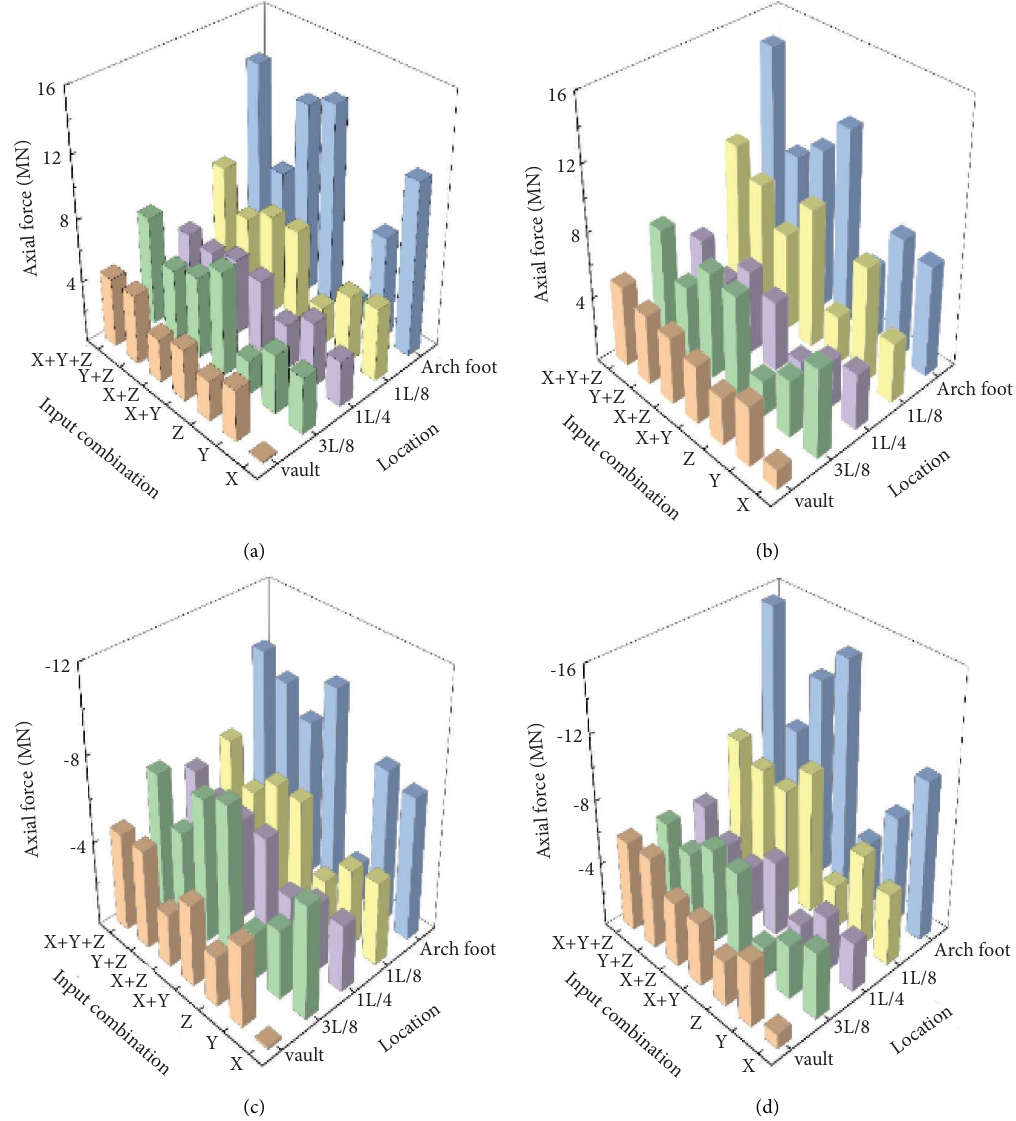
Figure 6: Axial force diagram of chord under multidimensional excitation. (a) Upper chord ( N max), (b) lower chord ( N max), (c) upper chord ( N min), and (d) lower chord ( N